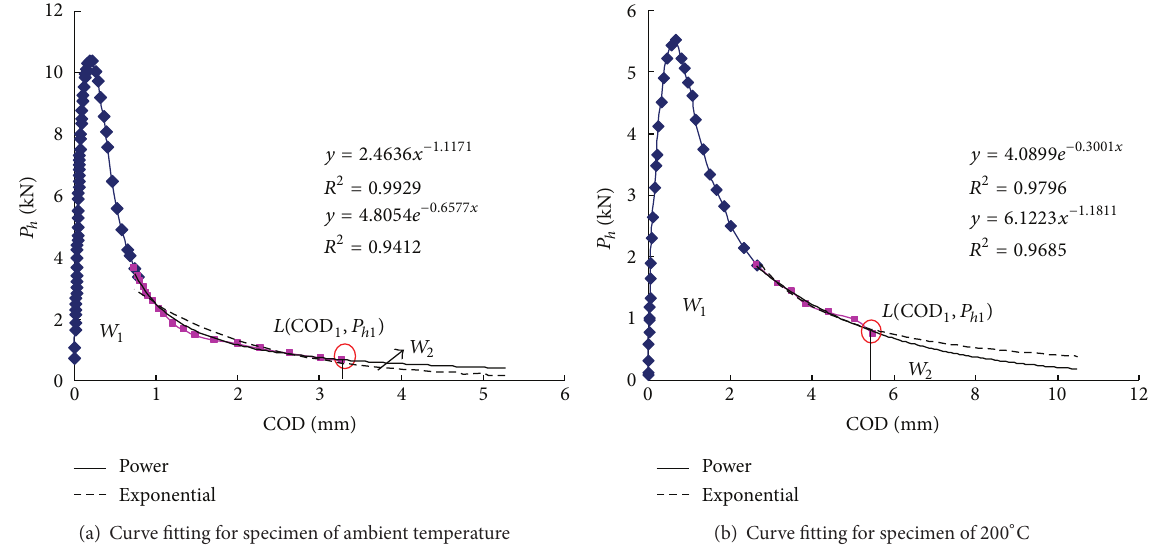
Figure 9: 𝑃 -CMOD tail curve fitting of specimens.